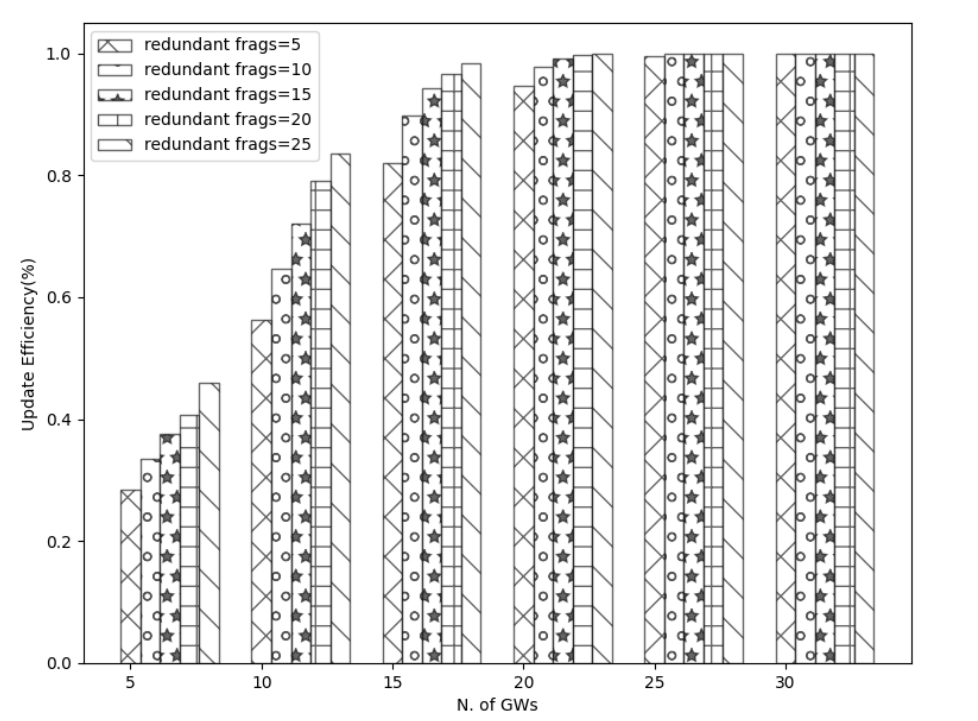
Figure 10. Effect of redundant fragments in update